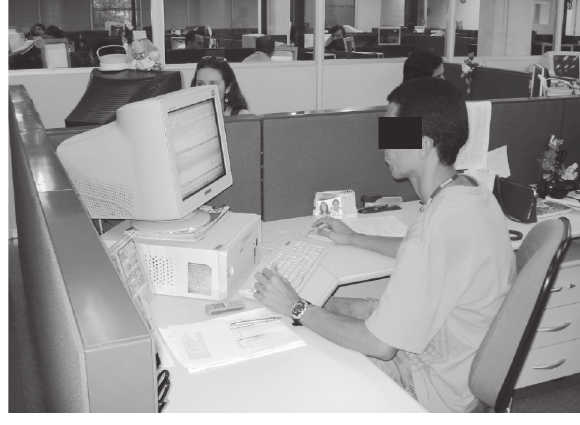
Figura 1 - Postura inadequada (sentado inclinado para frente, sem apoiar as costas no apoio da cadeira)